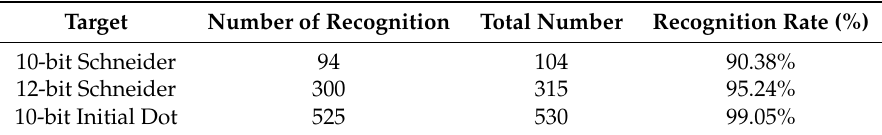
Figure 10. Four experimental device diagrams. Table 5. Analysis of decoding results of 3